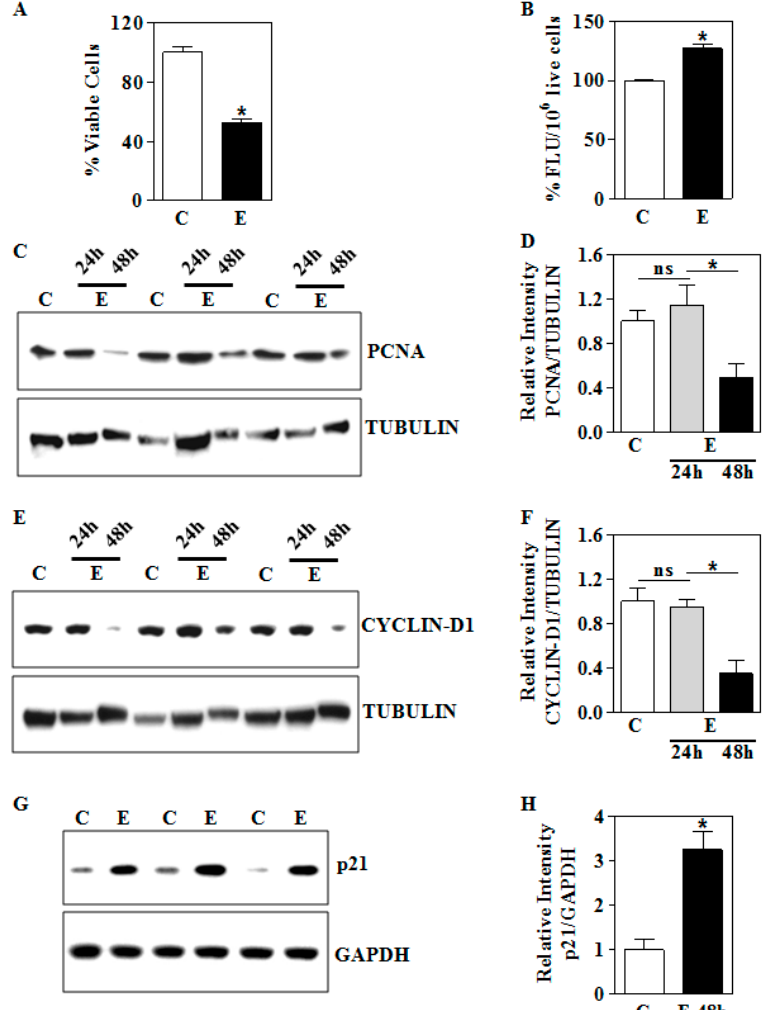
Figure 6. In vitro ethanol effects on the viability and expression of growth-related proteins in HTR8/sv neo trophoblasts. ( A ) E-treatment at a concentration of 4 mg/mL of E was done for 48 h. The trophoblasts cell viability was measured using MTT assay and shown as percentage viable cells; ( B ) effect of 48 h E on intracellular ROS level measured by fluorometry after DCF-DA treatment. The results are expressed as percentage fluorescence units (FLU) per the cell number; ( C ) equal amounts of proteins from E-treated trophoblasts at the indicated time points were resolved by SDS-PAGE and subjected to immunoblot directed against PCNA and a representative blots are shown; ( D ) graphical representation of the quantification of PCNA normalized to TUBULIN expression; ( E ) representative immunoblot for CYLCIN-D1 protein expression following E exposure; ( F ) semi-quantitative analysis of CYCLIN-D1 and TUBULIN ratios of experiments from ( E ); ( G ) immunoblot analysis for p21 protein expression following 48 h E exposure of trophoblasts and GAPDH blots served as loading control; ( H ) the densitometric quantification of p21 normalized to GAPDH levels. Values represent the mean ± SEM from n = 6. * p < 0.05 was considered significant versus ethanol and ns indicates not significant.